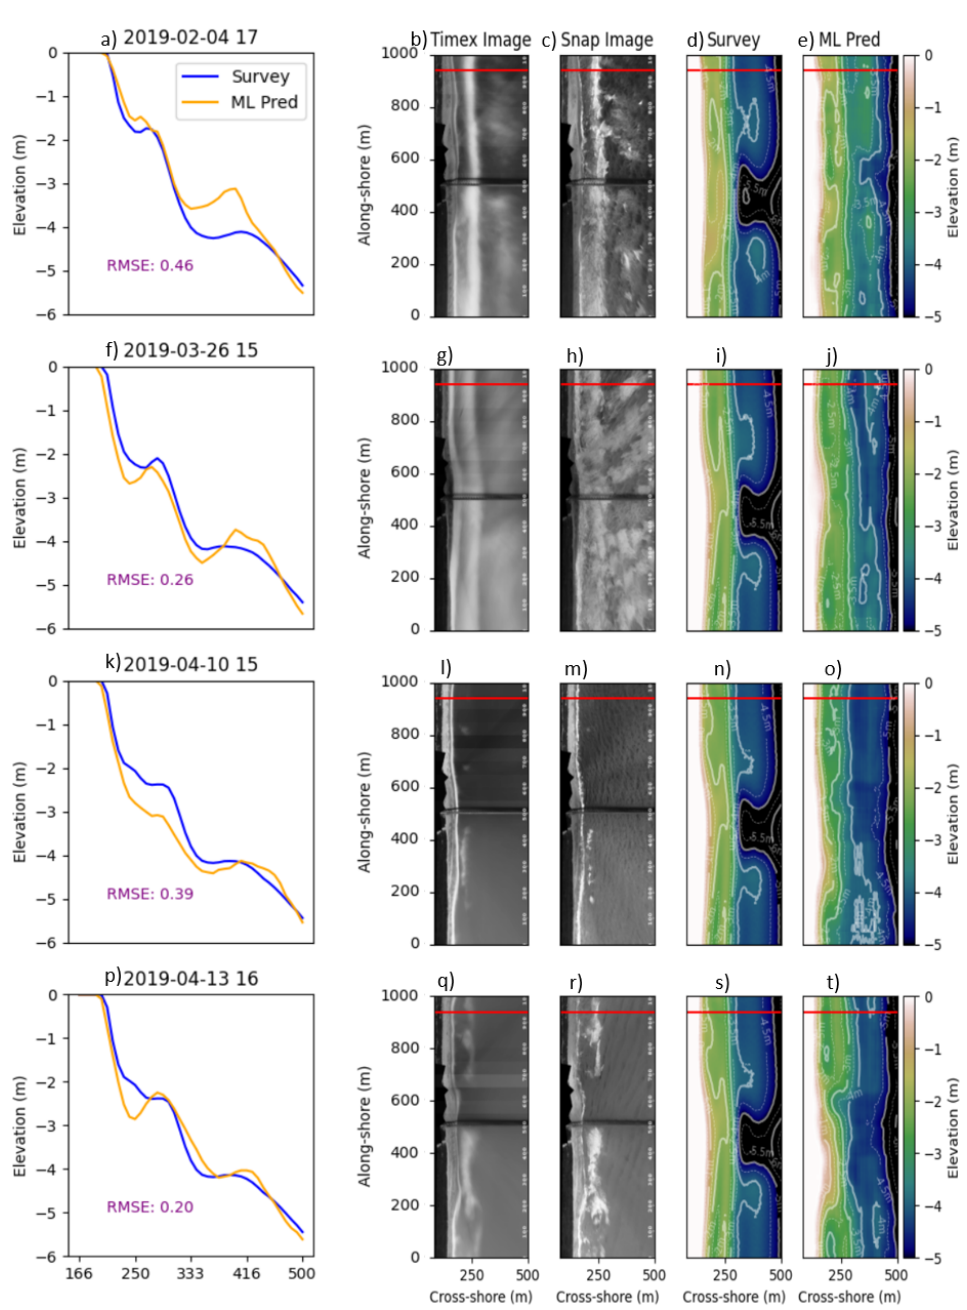
Figure 4. Example model results for four dates in the first half of 2019. For each date, subplots ( a , f , k , p ) plot elevation versus cross-shore position for a transect at 940 m in the along-shore from the interpolated survey product (orange) and the model prediction (blue). Subplots ( b , g , l , q ) plot the input Timex image; subplots ( c , h , m , r ) plot the input snapshot image; subplots ( d , i , n , s ) plot the interpolated survey bathymetry; and subplots ( e , j , o , t ) plot the model